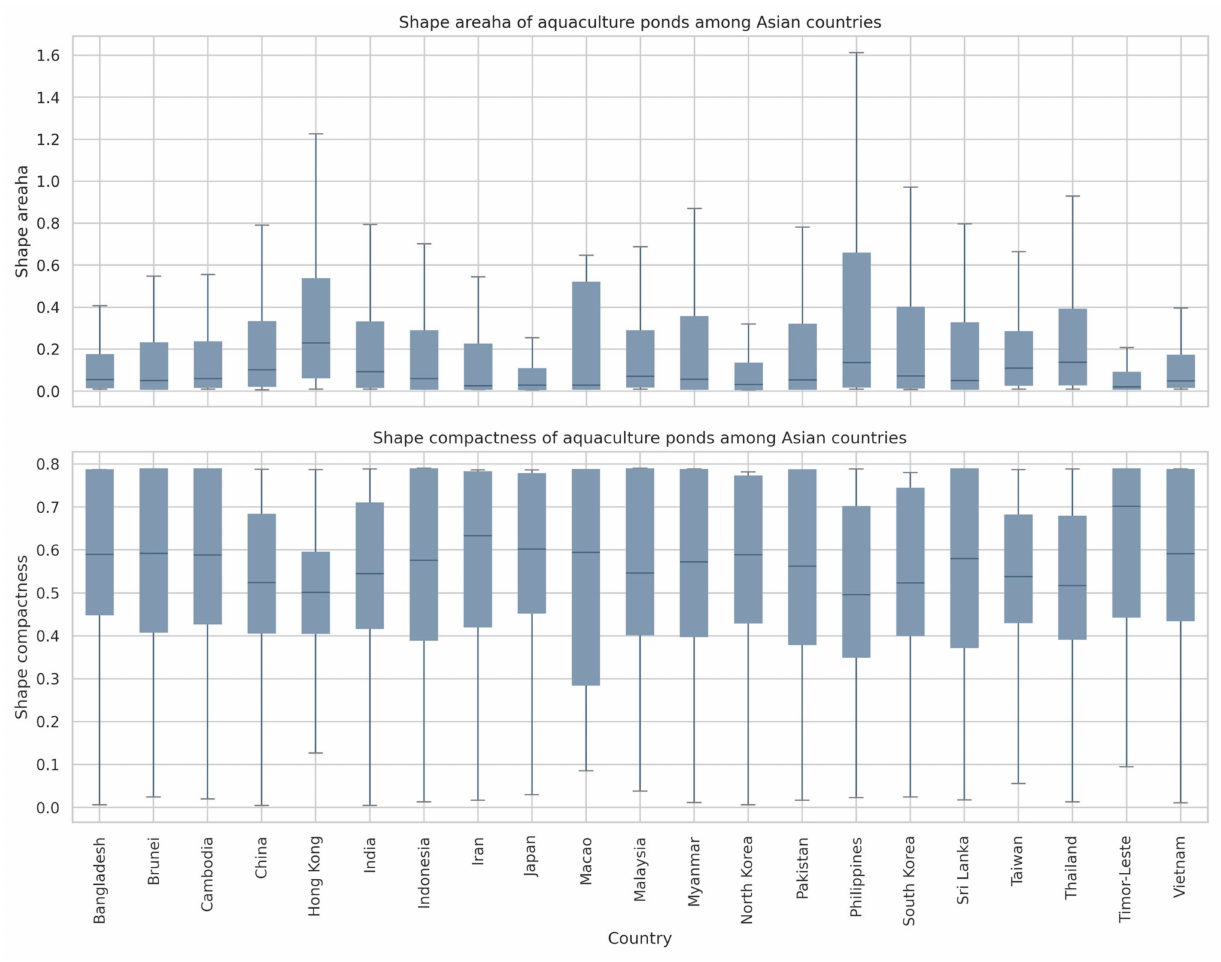
Figure 14. Comparative boxplots of the calculated area in ha (top) and compactness (perimeter 2 ∗ area) of the mapped coastal aquaculture ponds for each country in the coastal study